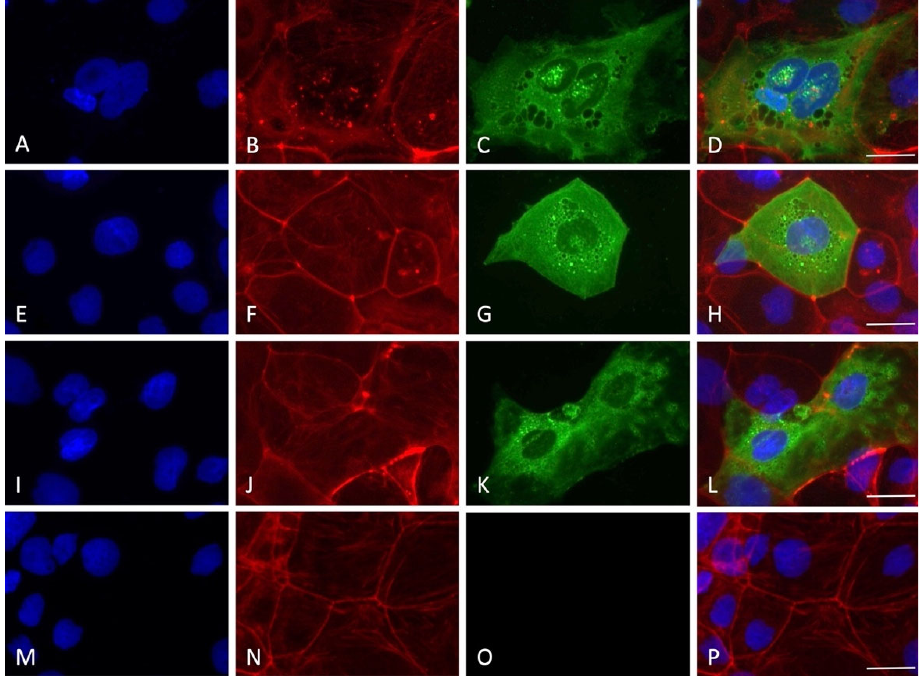
Figure 4. Immunofluorescence staining for nucleocapsid SARS ‐ CoV ‐ 2 protein with the experimental protocol employing 60 min of viral absorption (60× magnification, scale bar 30 micron). The fluorescence for nucleus (blue), F ‐ actin cytoskeleton (red), nucleocapsid protein of SARS ‐ CoV ‐ 2 (green) and the merge of the three channels are displayed. ( A – D ) MOI 0.1; ( E – H ) MOI 0.01; ( I – L ) MOI 0.001; ( M – P ) MOI 0.0001.